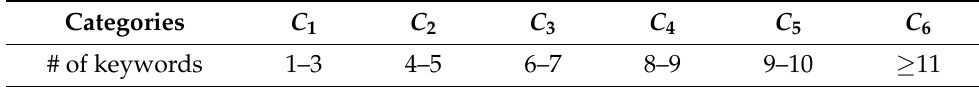
Table 2. Categories for the Boolean